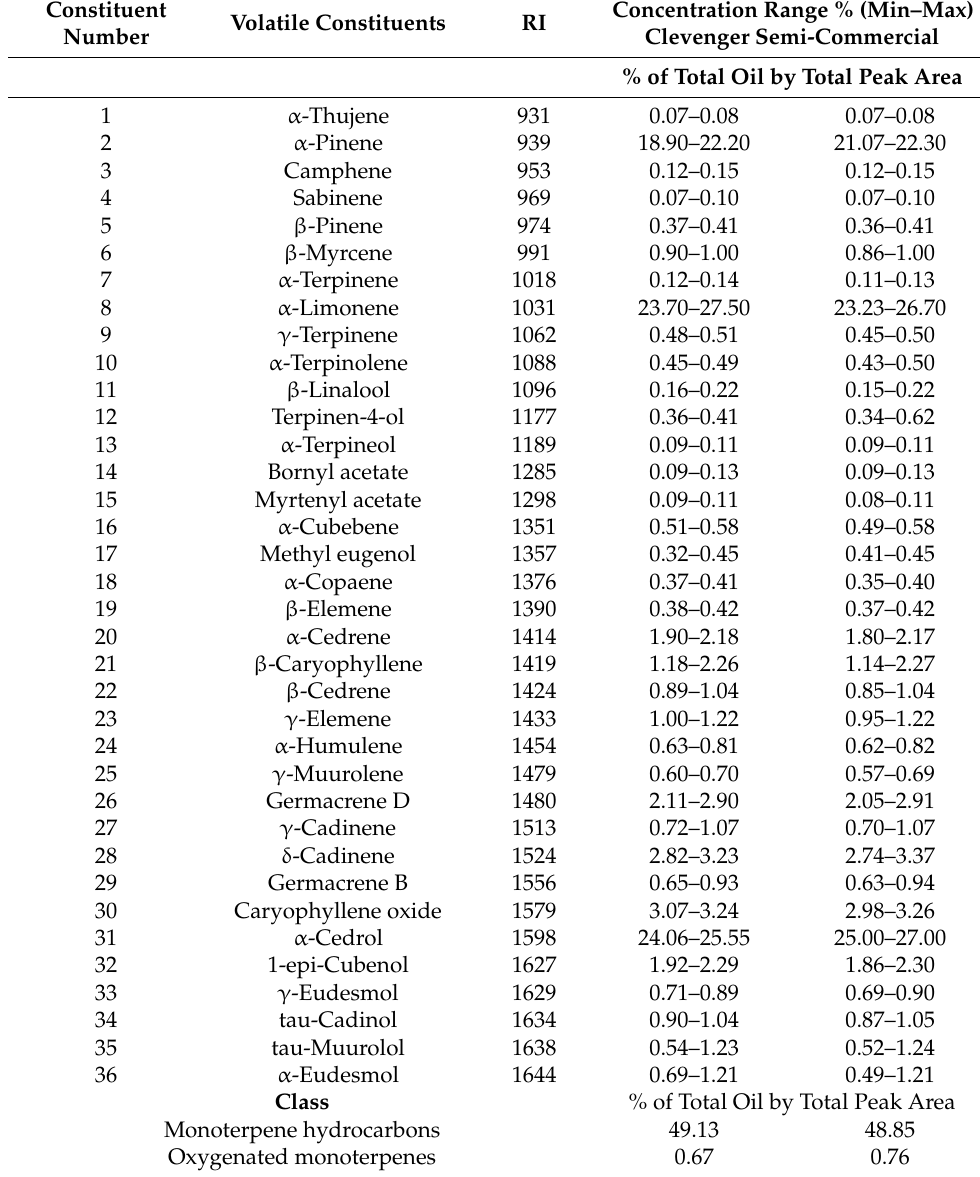
Table 6. Average concentration of Juniperus excelsa constituents (% of the total oil in the dried bimoass) extracted using two different methods: hydrodistillation (in Clevenger apparatus) and steam distillation (in a semi-commercial